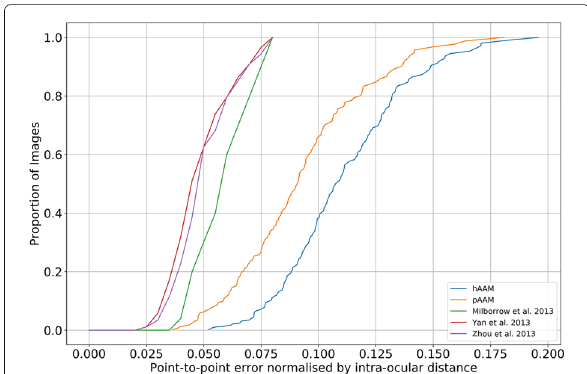
the Menpo competition results [57] is that many of the entries used some CNN-based method. The highest per- formers employed sophisticated deep learning approaches such as stacked hourglass and fully end-to-end convo- lutional networks, e.g. Chen et al. [63] who reported the maximum normalised frontal Menpo error to be less than 0.05.